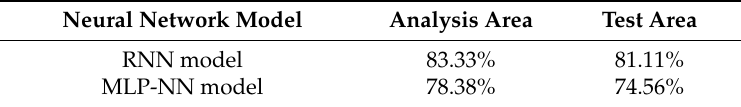
Table 5. Cross-validation accuracy results of the proposed